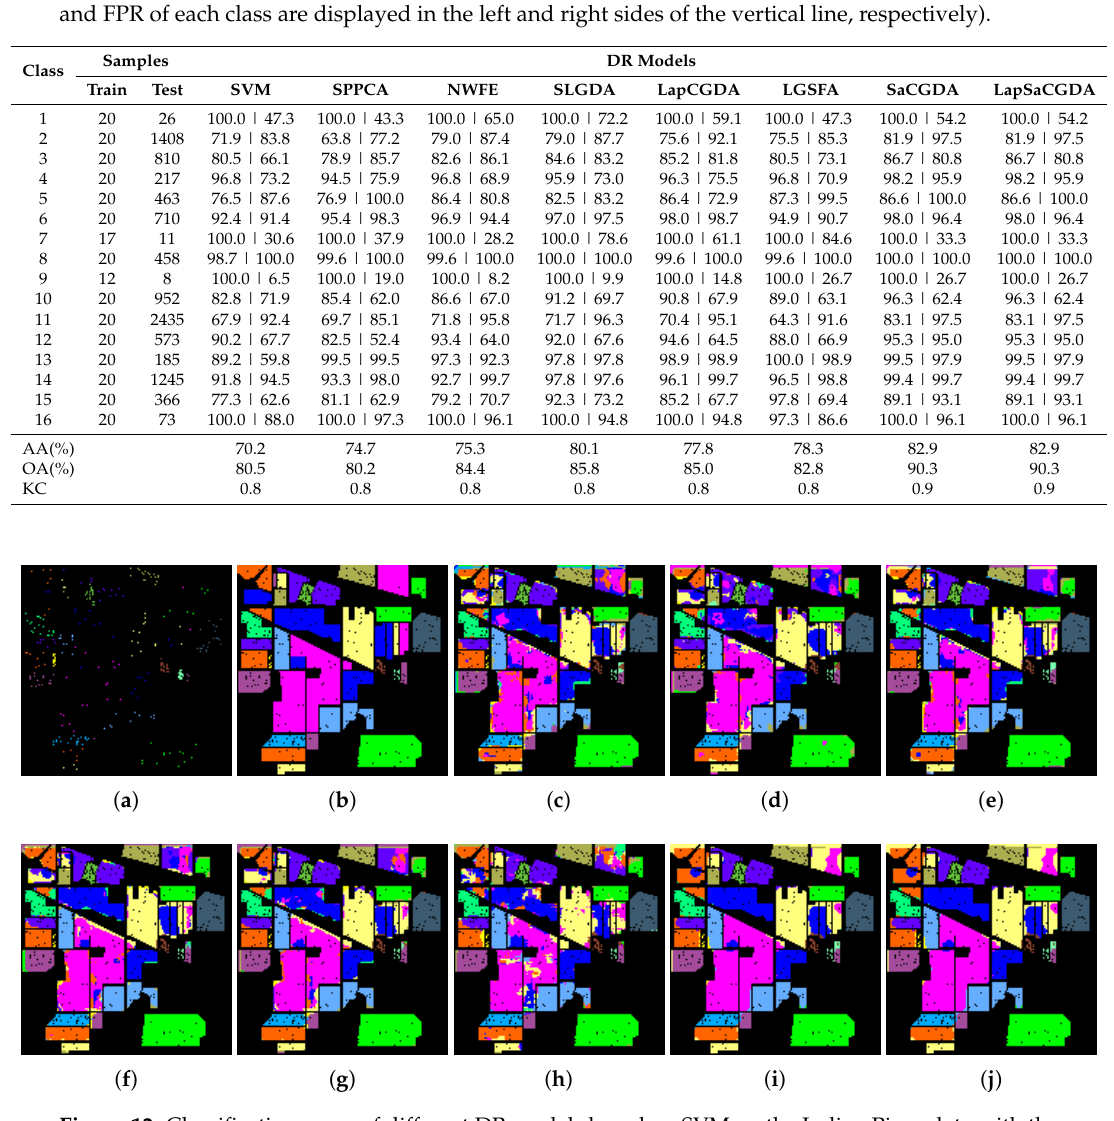
Figure 12. Classification maps of different DR models based on SVM on the Indian Pines data with the Ground Truths (GTs) corresponding to the training and testing data. ( a ) Training GT. ( b ) Testing GT. ( c ) SVM. ( d ) SPPCA. ( e ) NWFE. ( f ) SLGDA. ( g ) LapCGDA. ( h ) LGSFA. ( i ) SaCGDA. ( j )